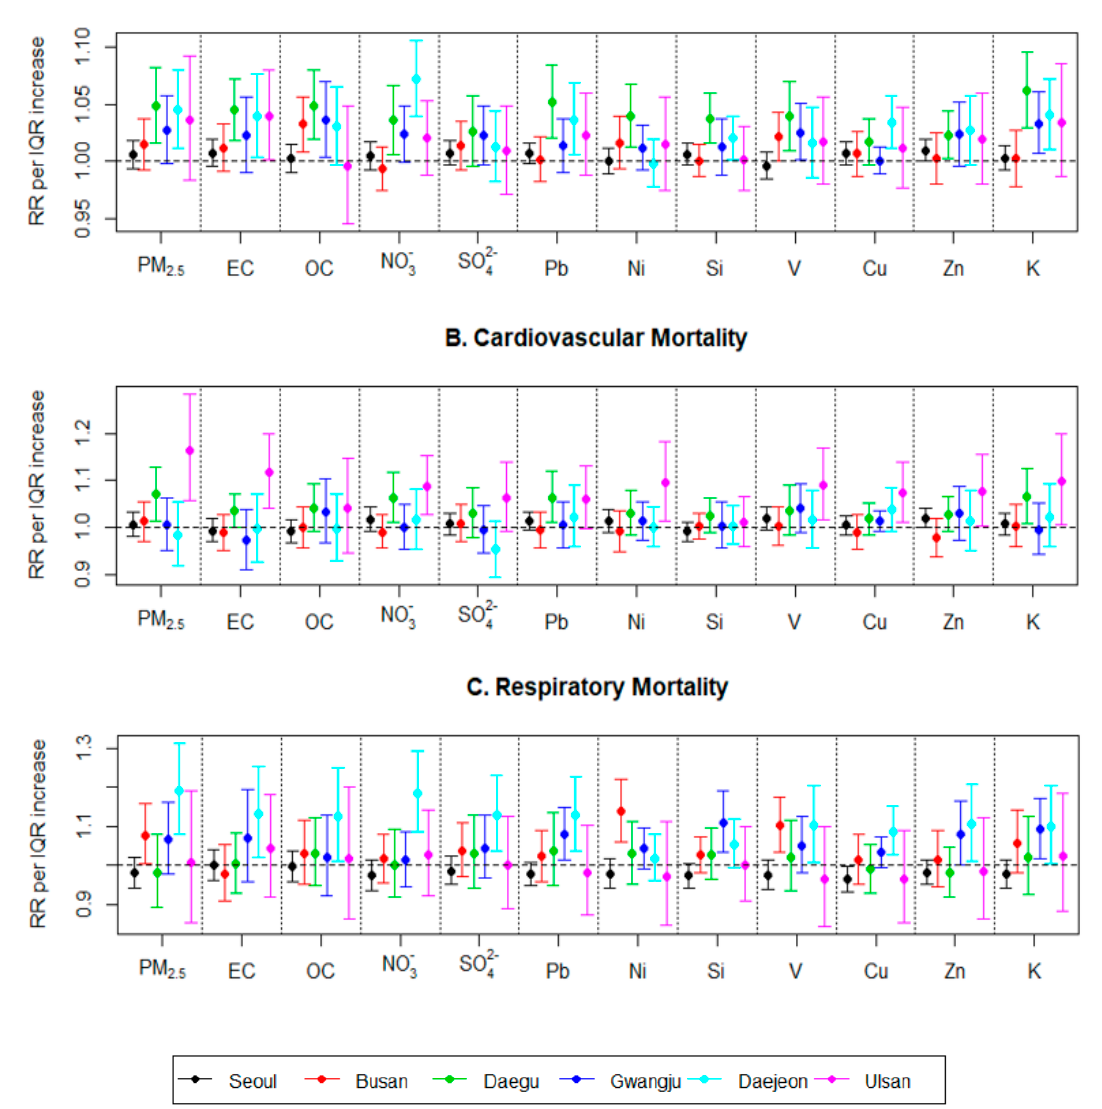
Figure 2. Relative risks (RRs) and 95% confidence intervals of daily nonaccidental, cardiovascular and respiratory mortality for interquartile range increases (IQR) in daily concentrations of PM 2.5 and 11 PM 2.5 chemical components across the six South Korean major cities from 2013 to 2015.